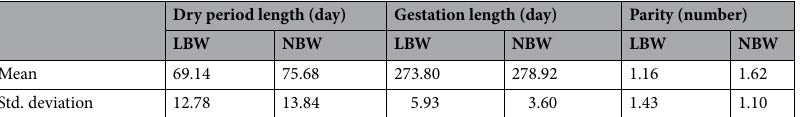
Table 1. Average of dry period length, gestation length, and parity of cows that gave birth to calves with low birth weight (LBW) and high birth weight (NBW).